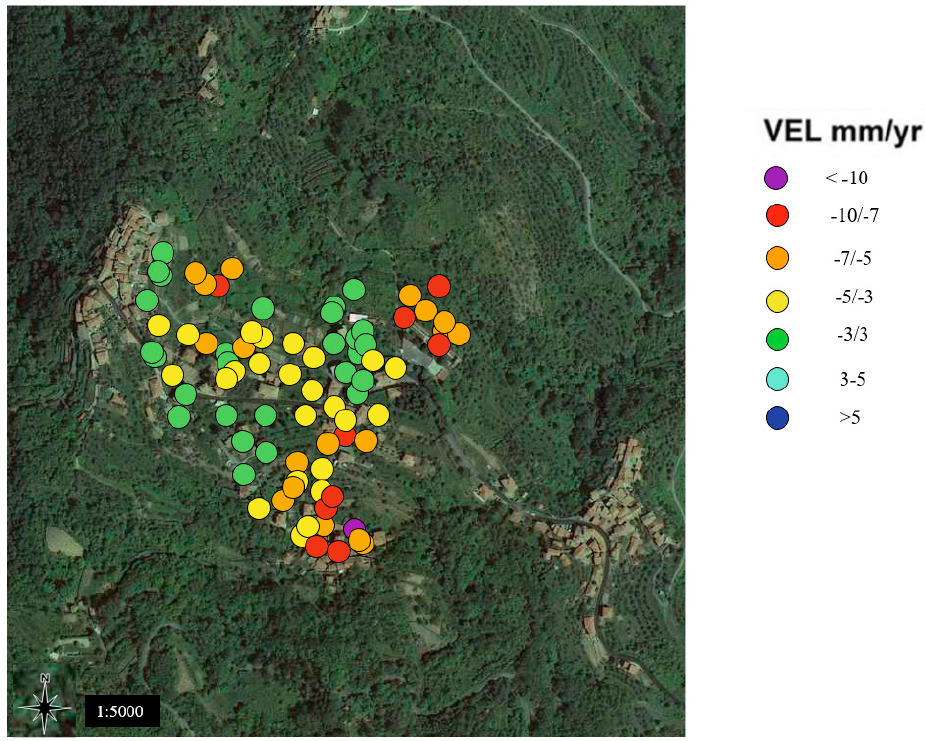
Figure 9. Permanent Scatter positions and velocities (projected along the slope) at Ville San Pietro.